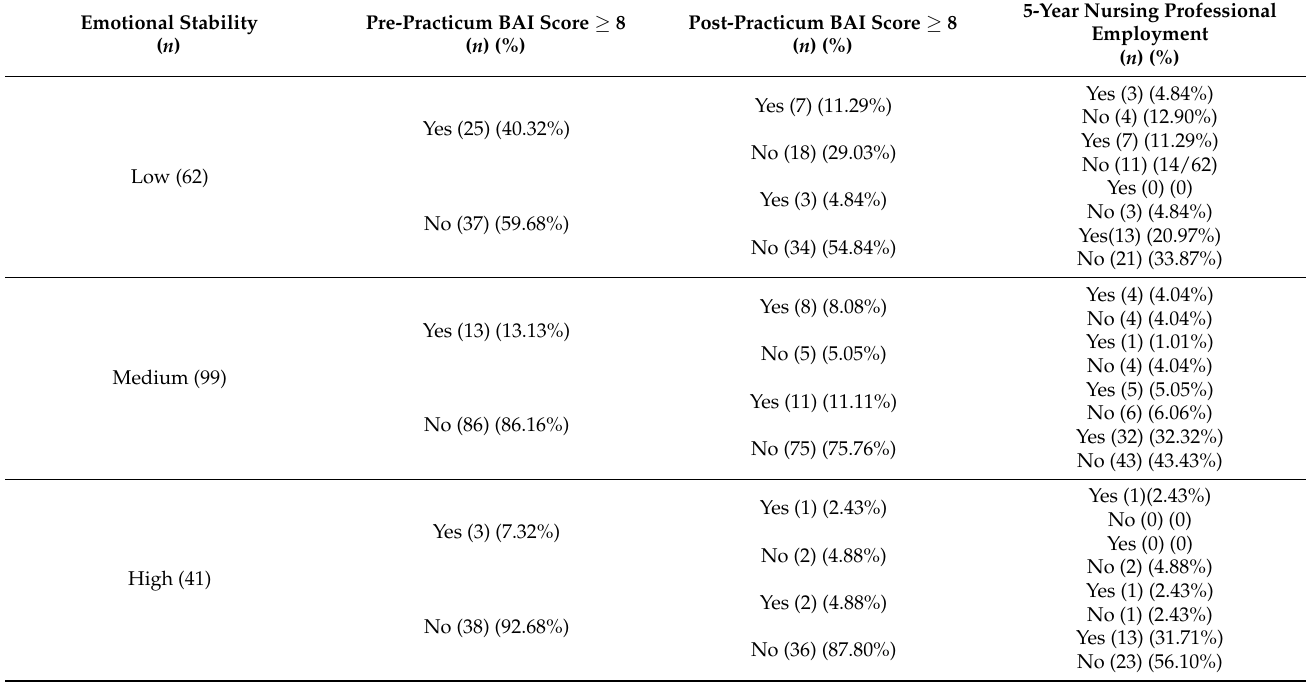
Table 3. Comparison of the anxiety score in clinical practicum and the 5-year nursing professional employment of in-service participants in 2021 according to the emotional stability level ( n = 202).